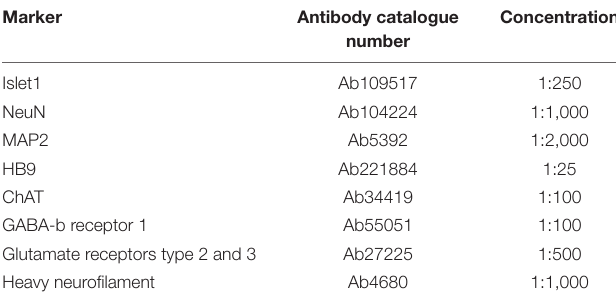
TABLE 1 | Immunocytochemistry (ICC): Markers, antibodies and concentrations.